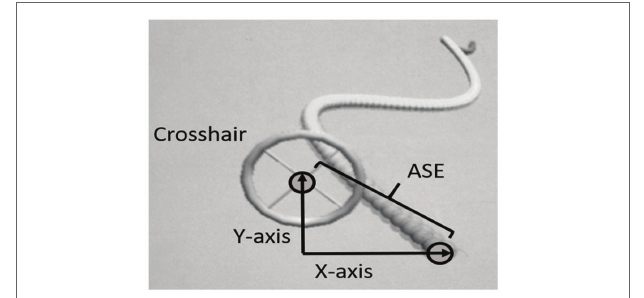
FIGURE 1 | Design of the “moving snake” and calculation of absolute spatial error